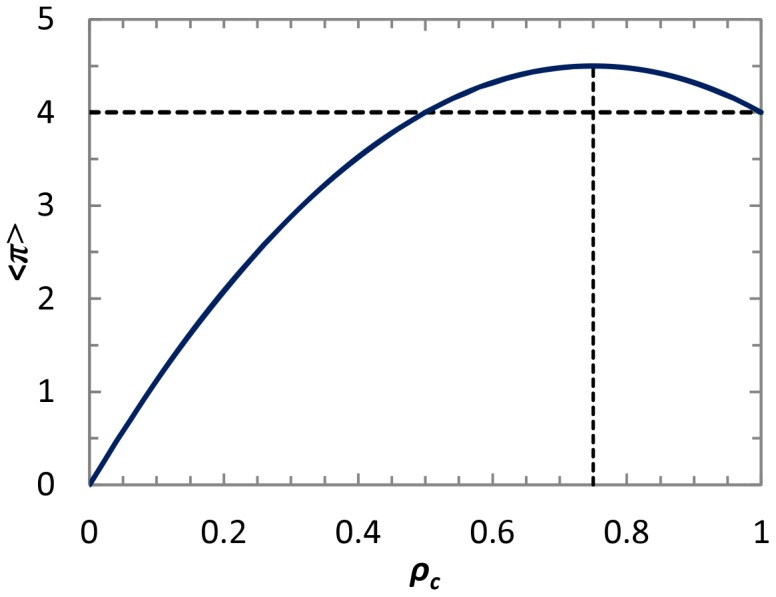
Expected payoff  as a function for fraction of cooperation  at Dg  =  −Dr  = 1, which is obtained by applying mean-field approximation approach.It is a quadratic function curve. Therefore, there is a cooperation fraction to guarantee the highest expected payoff . For example, in the Fig. 4, best social payoff  (exceeding 4R) is supported by  (indicated by dotted line.).